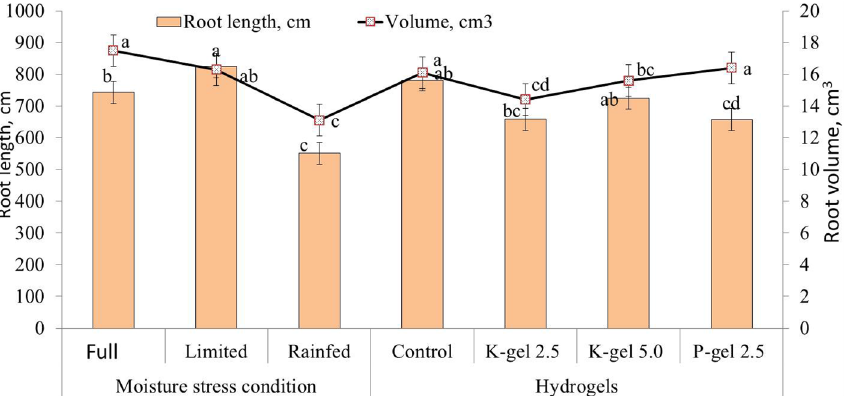
Figure 2. Individual effect of hydrogels and irrigation regimes on root length and volume of wheat in 2018–19. Bars indicate standard error of